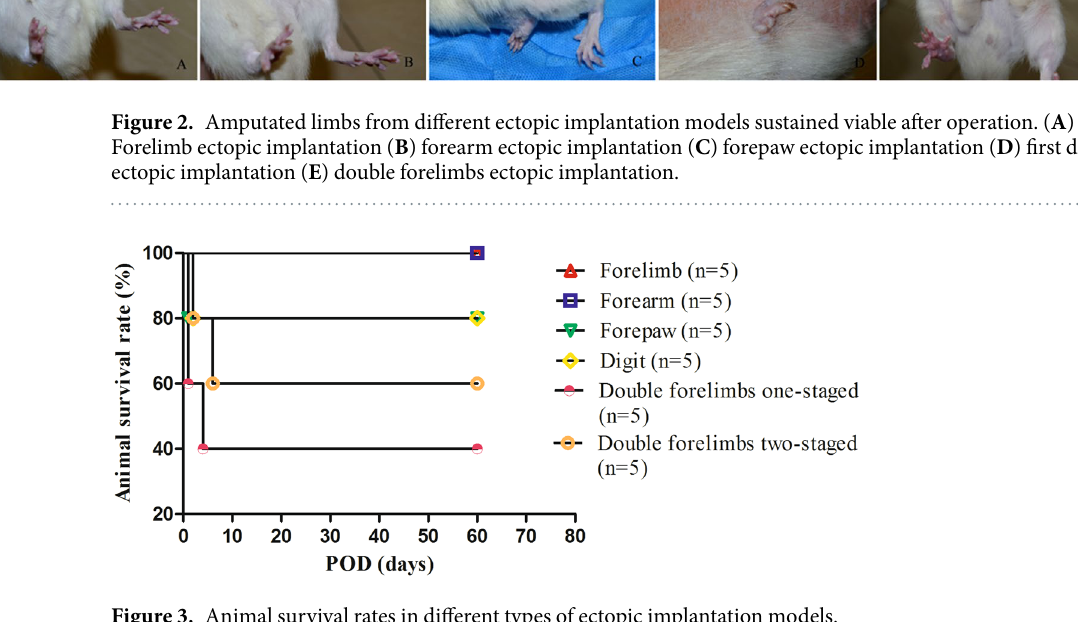
Figure 3. Animal survival rates in different types of ectopic implantation